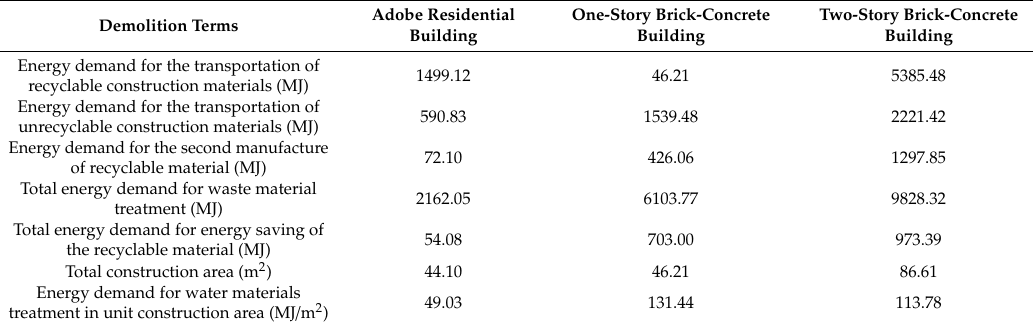
Table 21. Energy demand in the recyclable process for construction materials